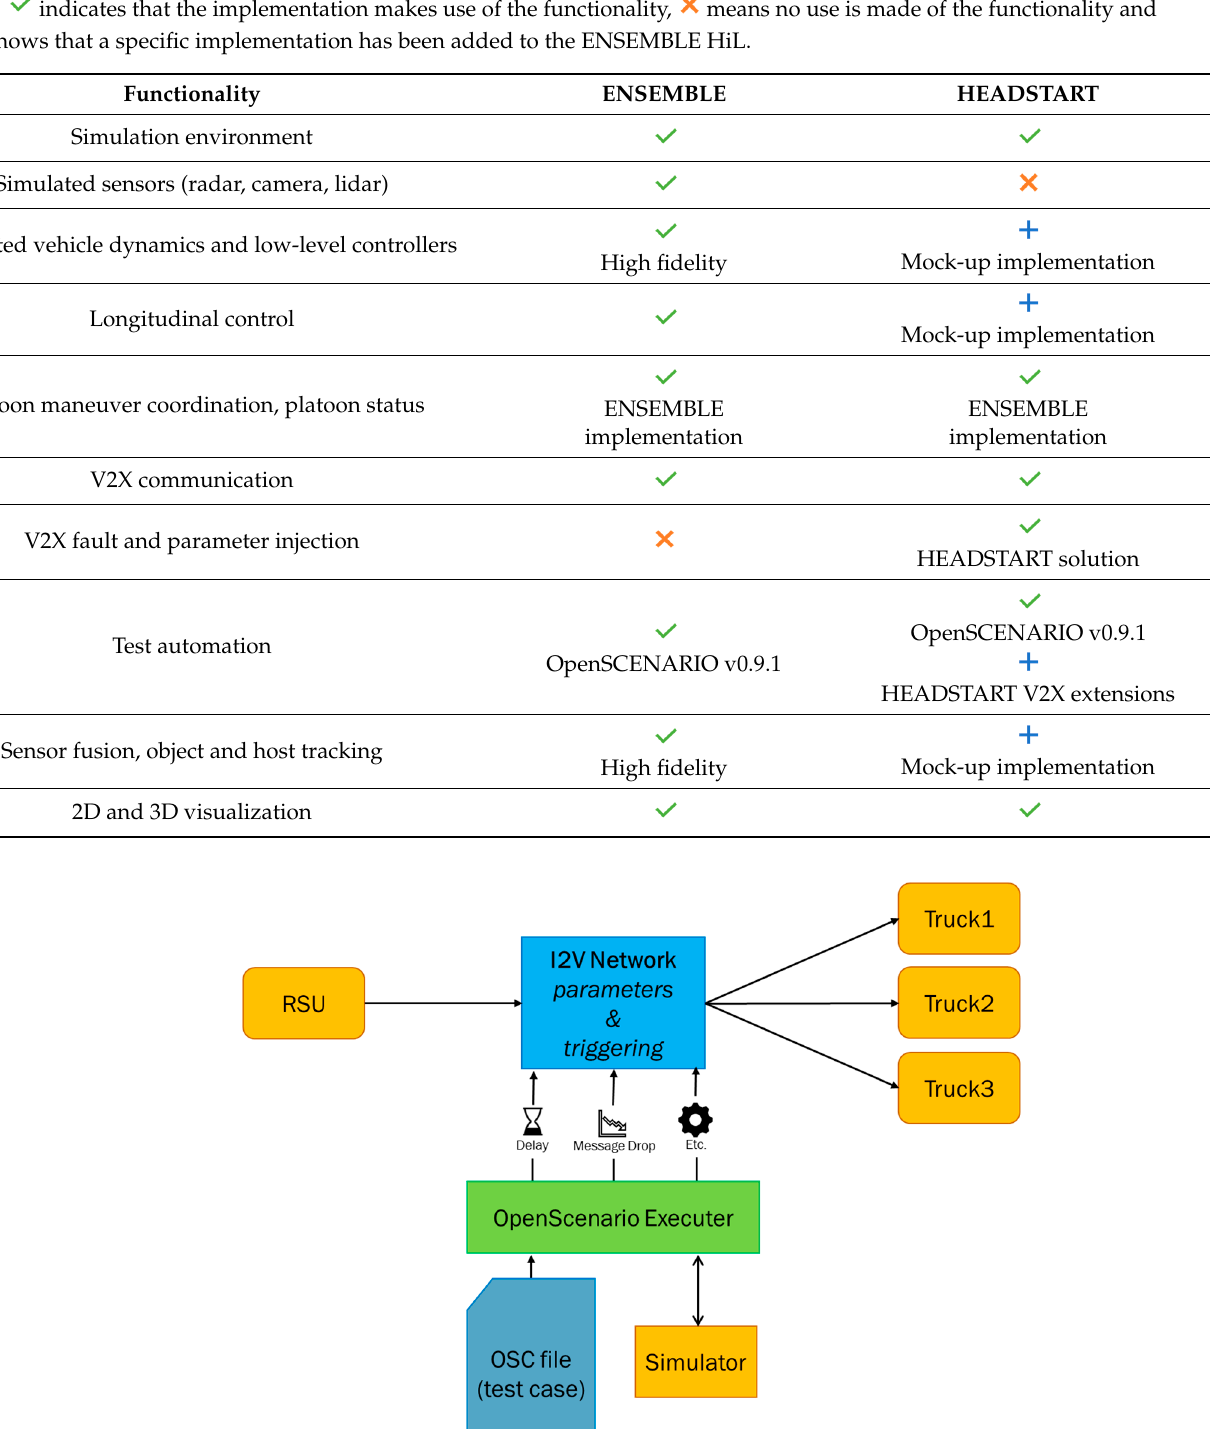
Figure 7. I2V network parameters and triggering conditions of failure modes: from RSU towards platooning vehicles.